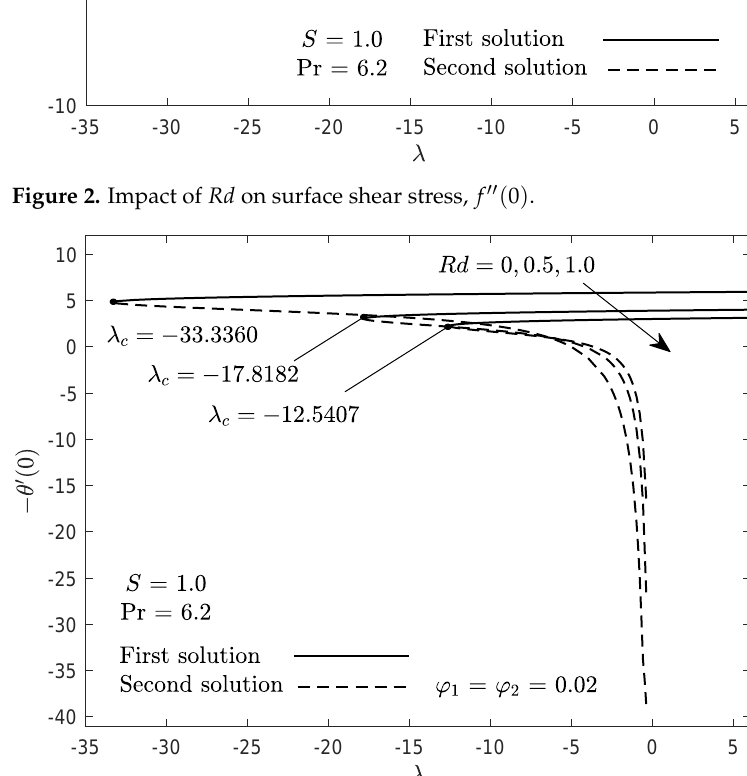
Figure 3. Impact of Rd on local heat flux, − θ (cid:48) ( 0 )